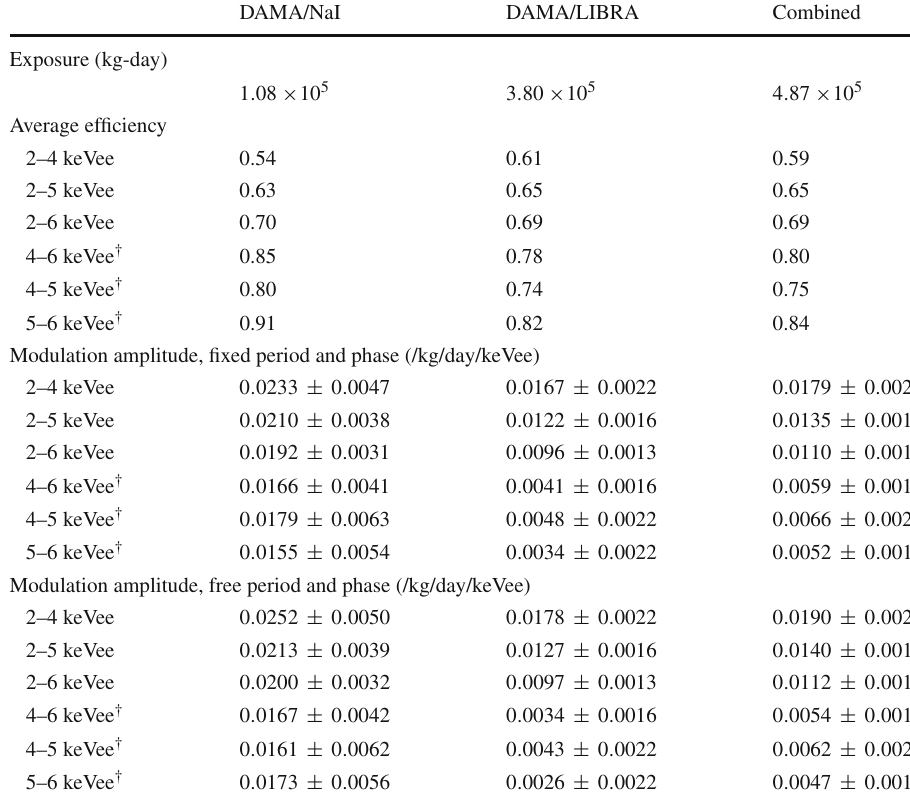
amplitudes for the DAMA/NaI, DAMA/LIBRA, and combined exposures.